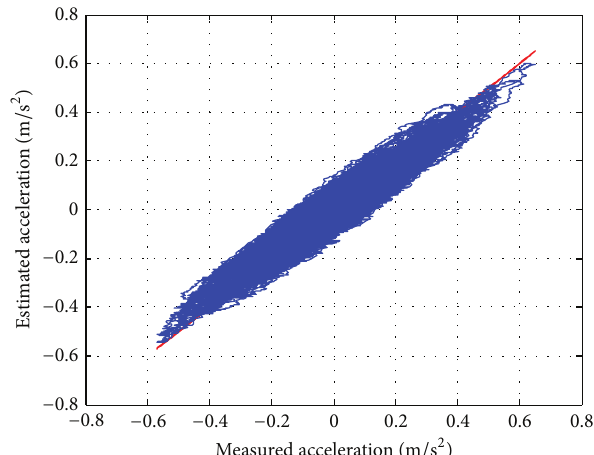
Figure 14: Correlogram between the measured and estimated acceleration for Case 3 (correlation coefficient =